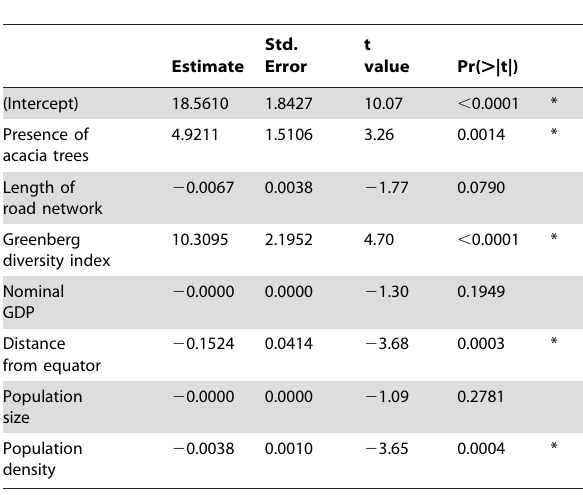
Table 5. Traffic accidents and acacia trees.